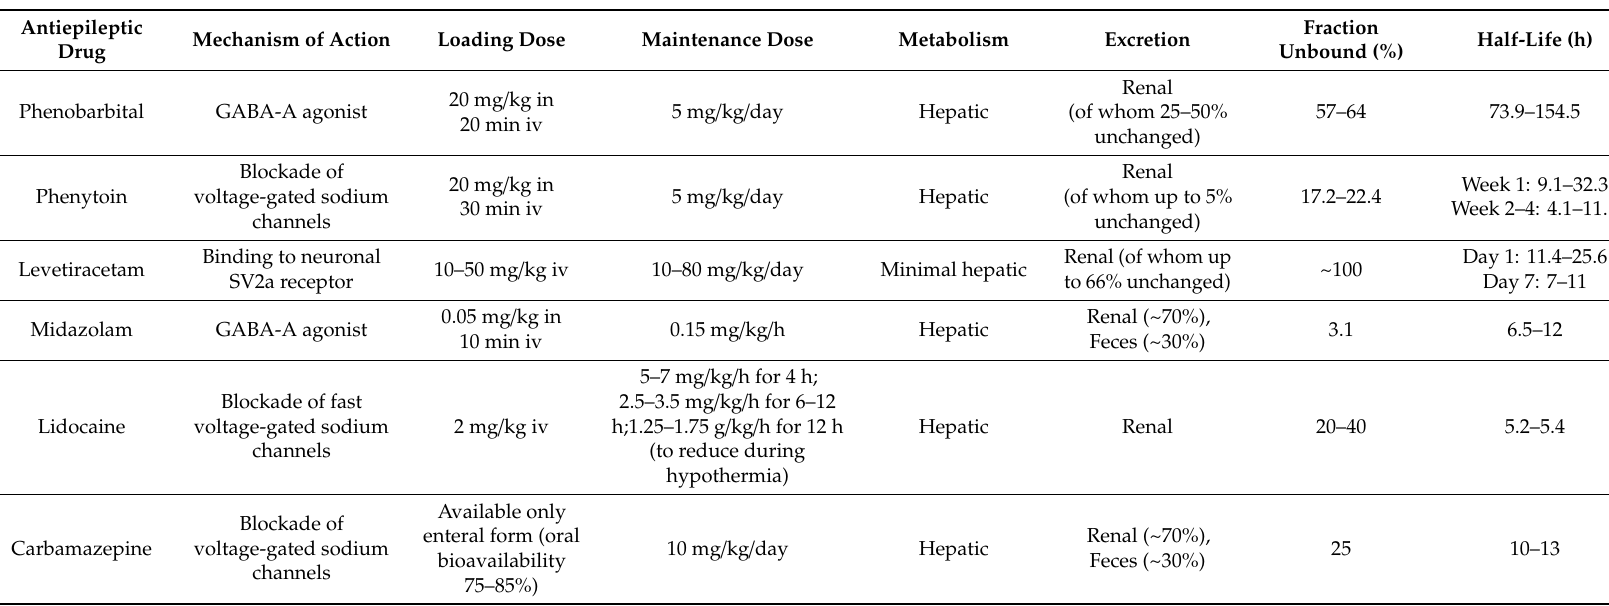
Table 3. Pharmacokinetics of most common antifungals titrated with TDM in newborns (modified from Donovan et al. [119] and Patsalos [120]). iv, intravenous. Antiepileptic